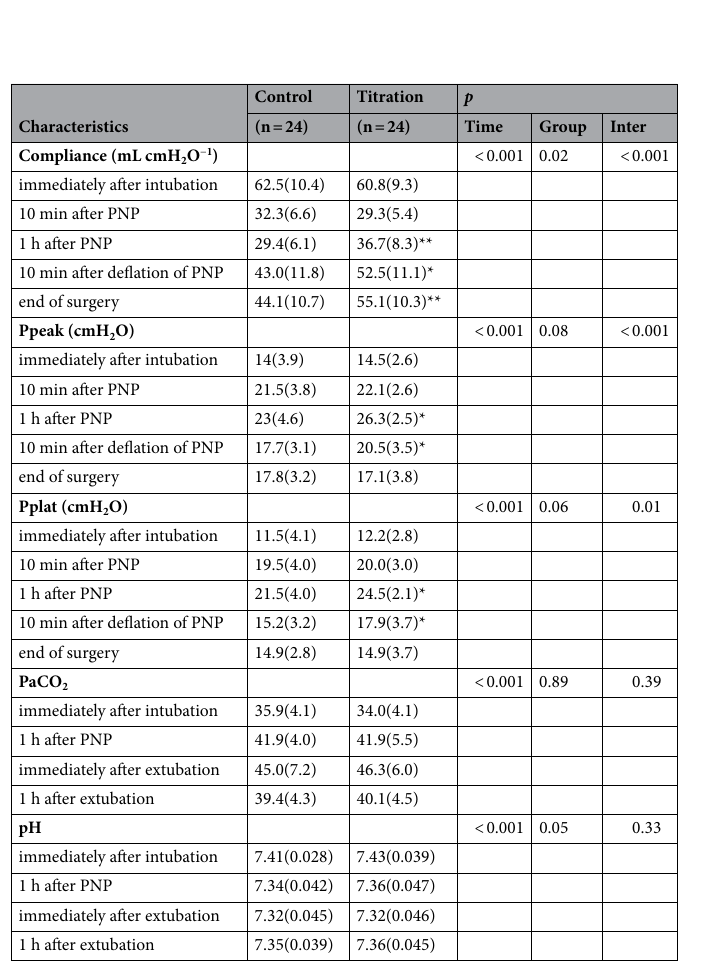
Table 2. Ventilatory mechanics and gas analysis. Values are the mean (SD) or number (%). Values are the mean (SD). Ppeak airway peak pressure; Pplat airway plateau pressure; PNP pneumoperitoneum. * p < 0.05; ** p < 0.01 compared to the control